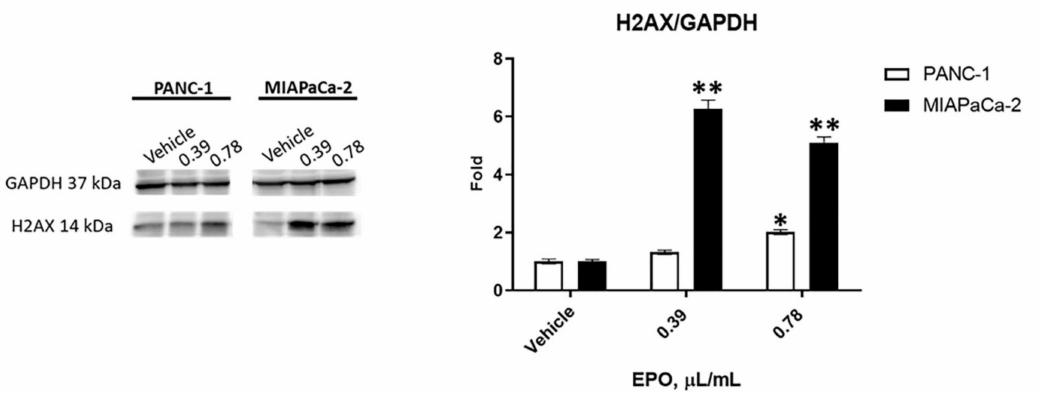
Figure 3. H2AX densitometric values were normalized to glyceraldehyde-3-phosphate dehydroge- nase (GAPDH) used as loading control. Densitometric values shown are the mean ± SD of three separate experiments. * p < 0.05, ** p < 0.01, treated PANC-1 or MIAPaCa-2 vs. vehicle.